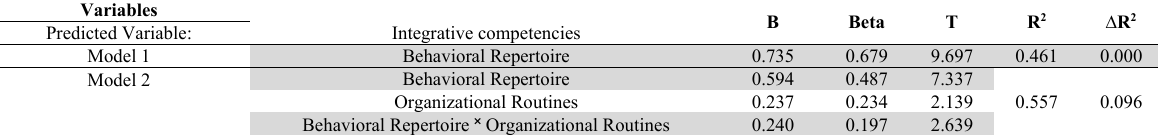
the results supported H1c by explaining the positive impact of behavioral repertoire on integrative competencies. (B=0.594, P<0.001). There was a significant interaction between behavioral repertoire and organizational routines (B=0.540, P>0.05). According to the findings, organizational routines had moderating effect on the relationship between behavioral repertoire and integrative competencies, thus supporting H2d. This mean, this relationship was changed depending on the organizational routines positively. The results of Hierarchical Regression Analysis of the moderating effect of organizational routines on the relationship between behavioral repertoire and integrative